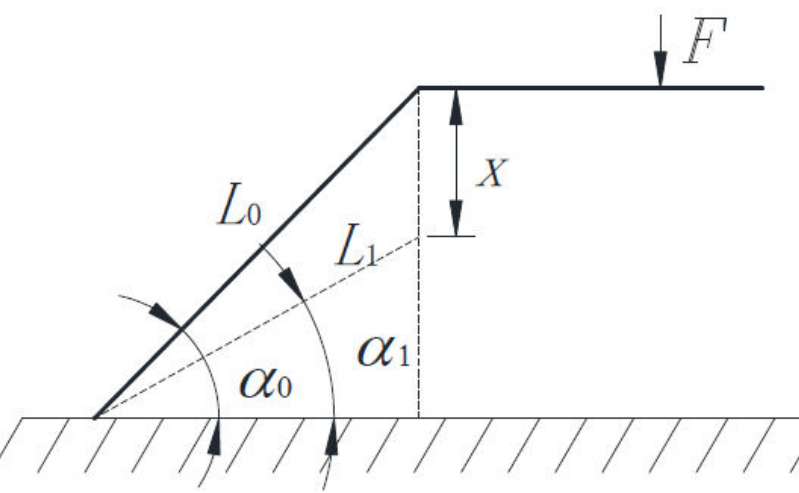
Figure 4. Schematic diagram of suspension spring force analysis.